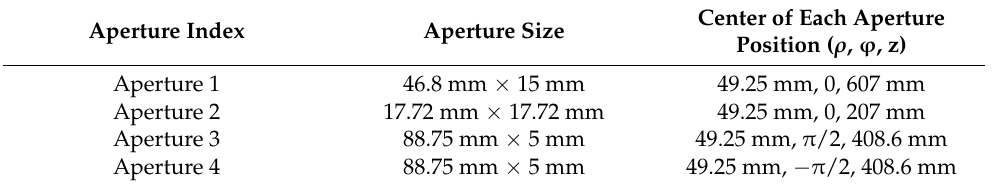
Table 1. Aperture sizes and positions on the